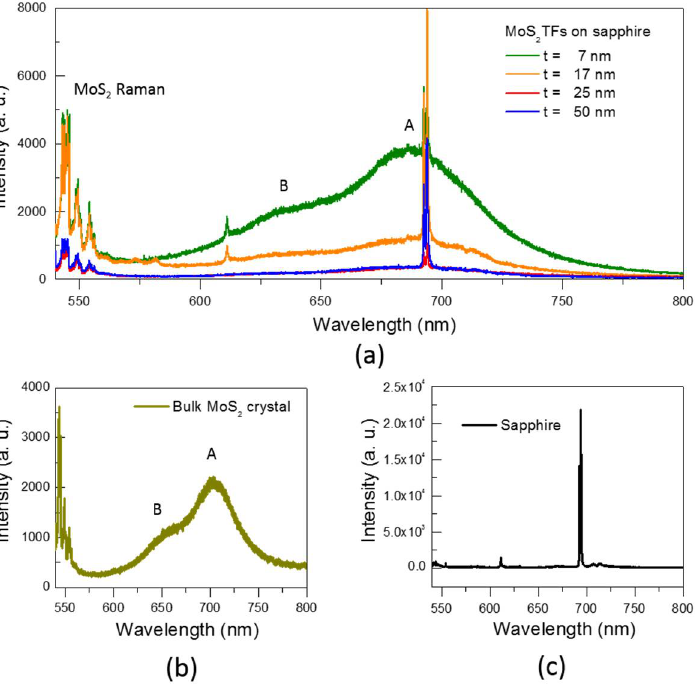
Figure 7. Photoluminescence spectra of ( a ) MoS 2 thin films grown on a sapphire substrate with different thicknesses, ( b ) sapphire, and ( c ) bulk MoS 2 crystal.